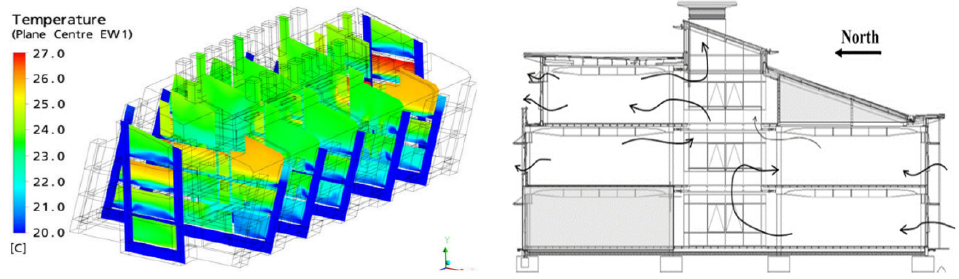
Figure 2. Buoyancy-driven NV design, ( Left ): Queens building at De Montfort University, Leicester, UK [15], ( Right ): Houghton Hall Office Building, Luton, UK [16,17].